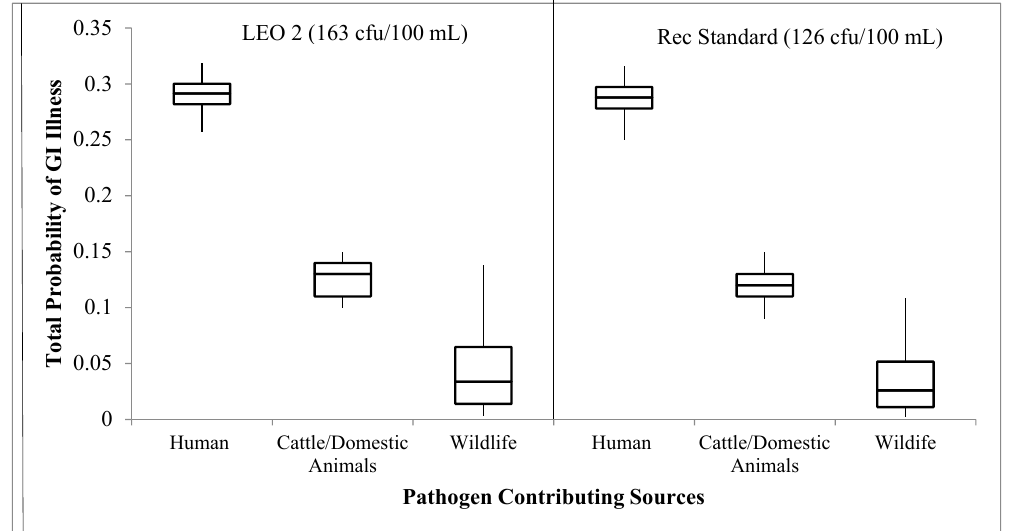
Figure 1. The calculated probabilities for a gastrointestinal (GI) illness under Scenario 1 (each source contributes 100%). The 5th, 25th, 75th, and 95th percentiles, as well as the median, are presented for the actual E. coli concentration (163 cfu 100 mL − 1 ) and current contact recreational standard (126 cfu 100 mL − 1 ).